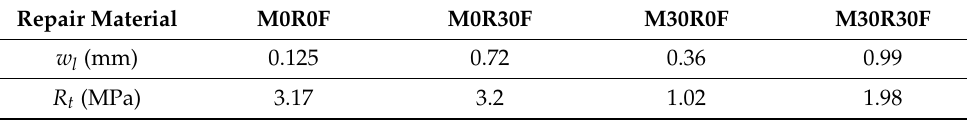
Table 6. Experimental data for calibrated